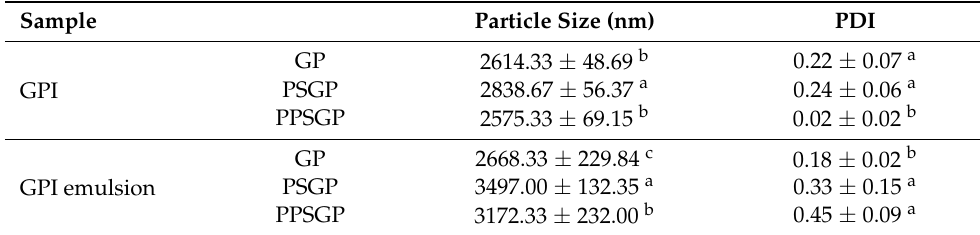
Table 1. Particle sizes of GP and GP emulsion.